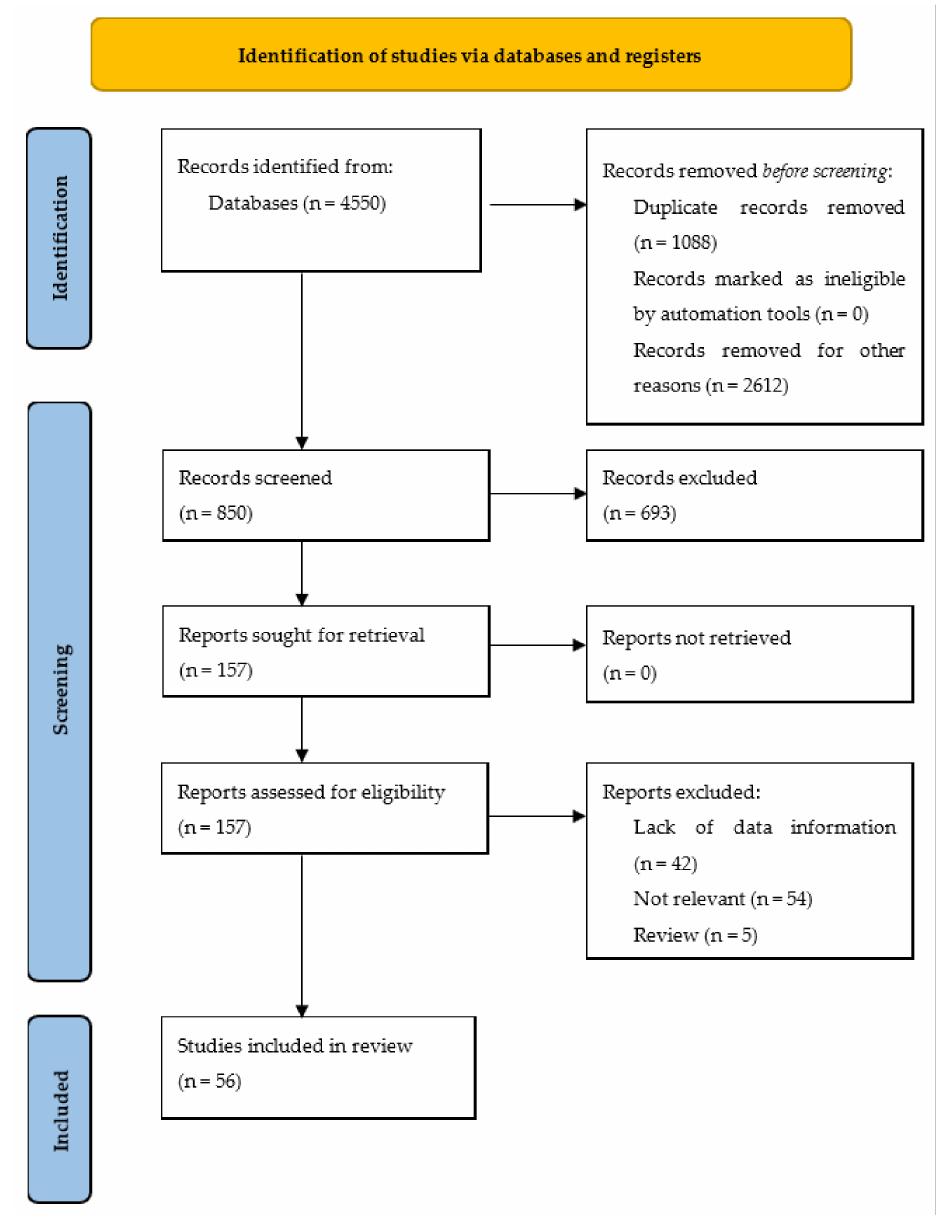
Figure 1. PRISMA 2020 flow diagram for new systematic reviews which included searches of databases and registers